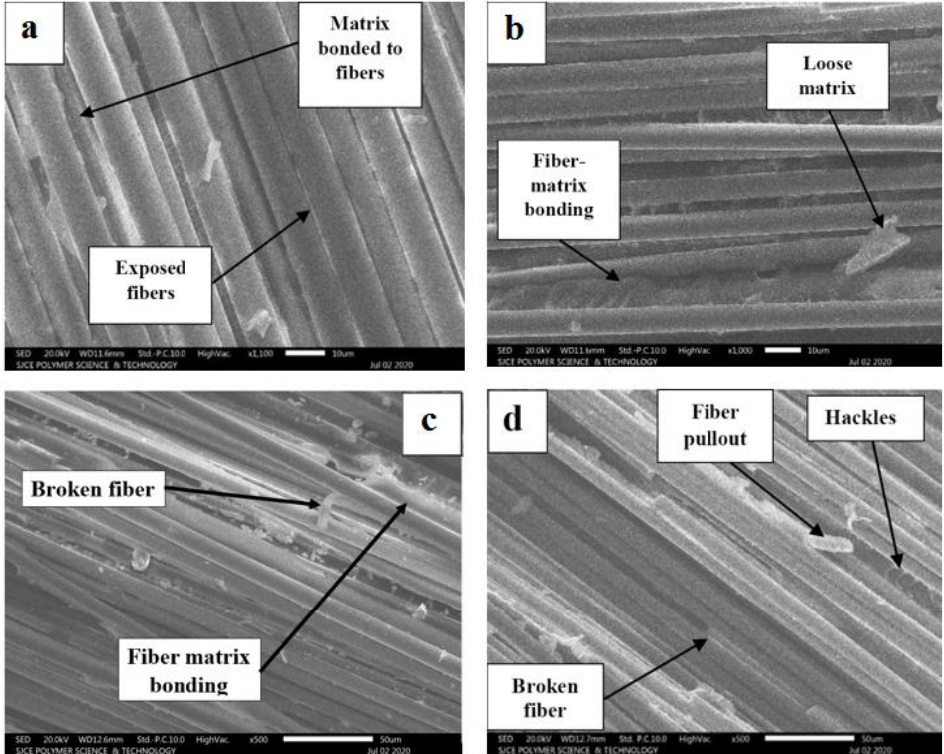
Figure 13. SEM micrographs from mode-I fractured delaminated surfaces of ( a ) GCE-RT ( b ) GCE-90-6 ( c ) GCE-135-6 ( d ) GCE-180-6.